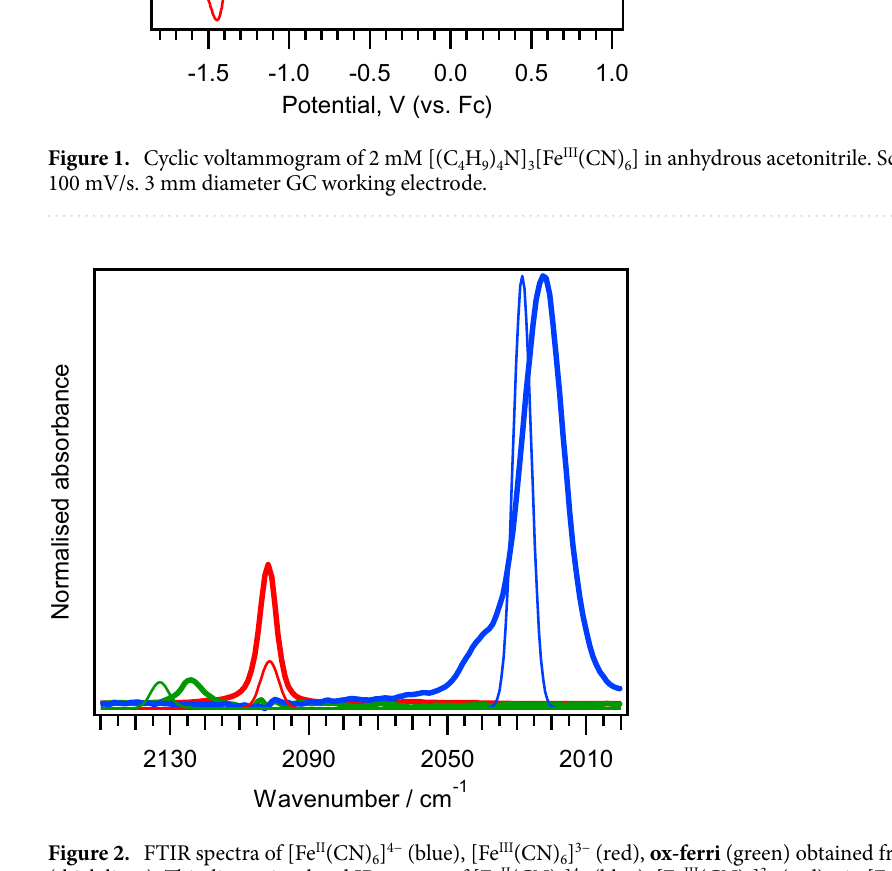
Figure 2. FTIR spectra of [Fe II (CN) 6 ] 4− (blue), [Fe III (CN) 6 ] 3− (red), ox-ferri (green) obtained from IR-SEC (thick lines). Thin lines: simulated IR spectra of [Fe II (CN) 6 ] 4− (blue), [Fe III (CN) 6 ] 3− (red), cis-[Fe III (CN) 4 (CH 1− (green) from DFT 3 CN) 2 ]